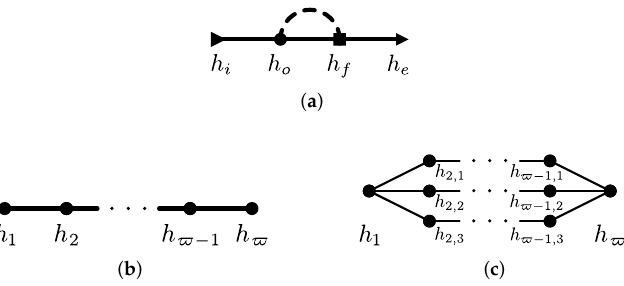
Figure 2. Example of ( a ) the metaheuristic representation based on signal-flow diagrams, where h o can be obtained from ( b ) a cascade or ( c ) a parallel